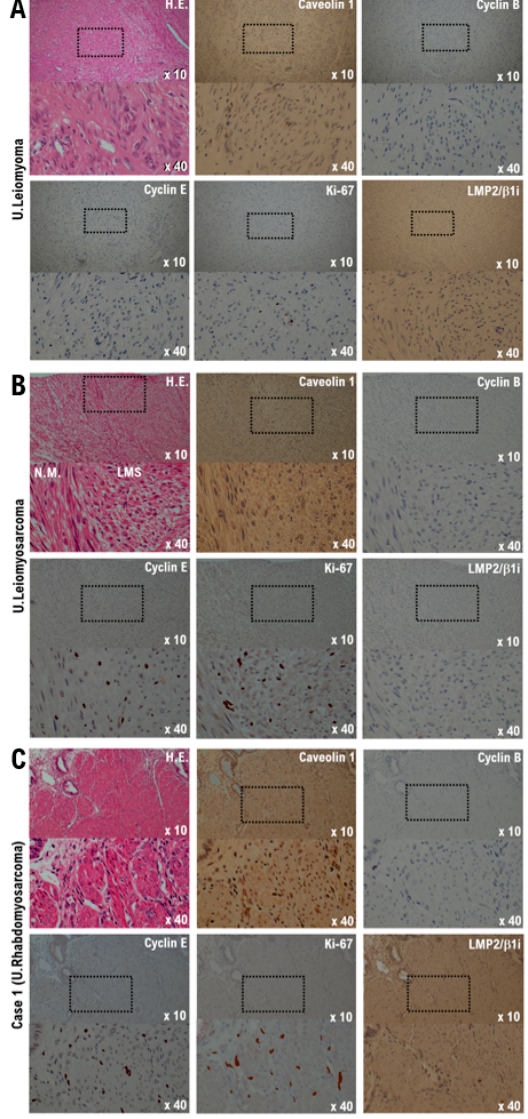
Figure 1. Figure 1. Differential expression of cyclin B, cyclin E, caveolin-1, ki-67, and LMP2/b1i as potential biomarkers in the normal myometrium, uterine leiomyoma, uterine leiomyosarcoma, and the Case